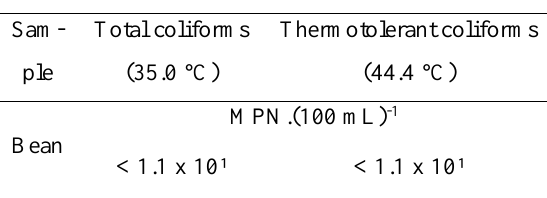
Table 7 Microbiological analysis of beans fertigated with